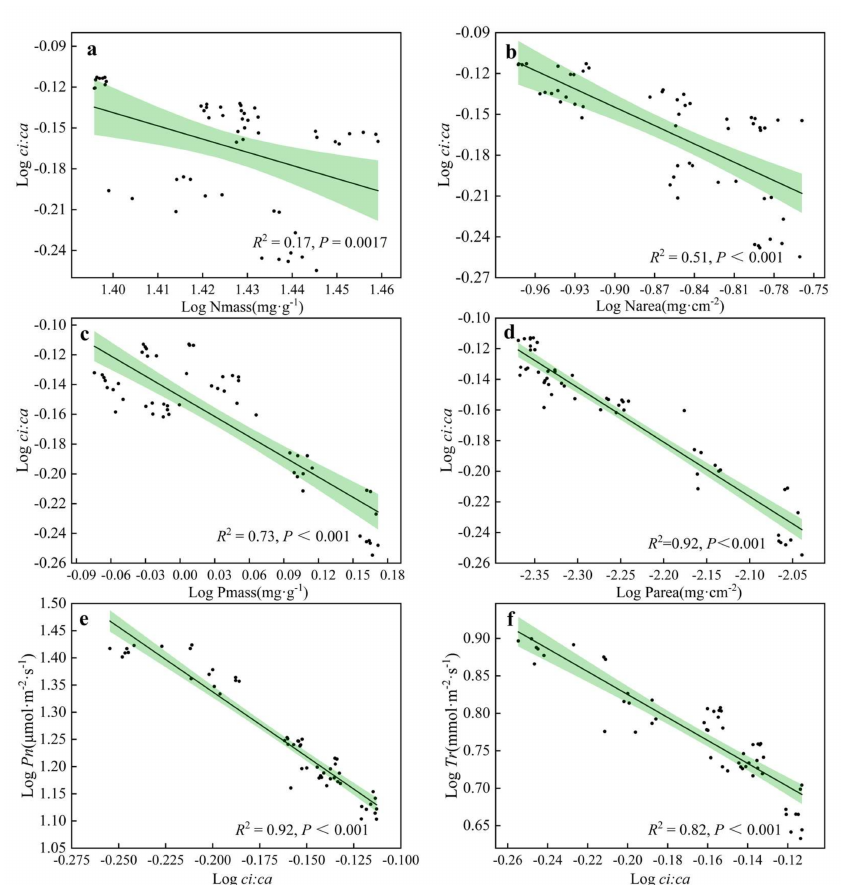
Figure 9. Linear regression relationship of ci:ca with other leaf functional traits. ( a ) Linear regres- sion relationship between Nmass and ci:ca . ( b ) Linear regression relationship between Narea and ci:ca . ( c ) Linear regression relationship between Pmass and ci:ca . ( d ) Linear regression relationship between Parea and ci:ca . ( e ) Linear regression relationship between Pn and ci:ca . ( f ) Linear regression relationship between Tr and ci:ca .